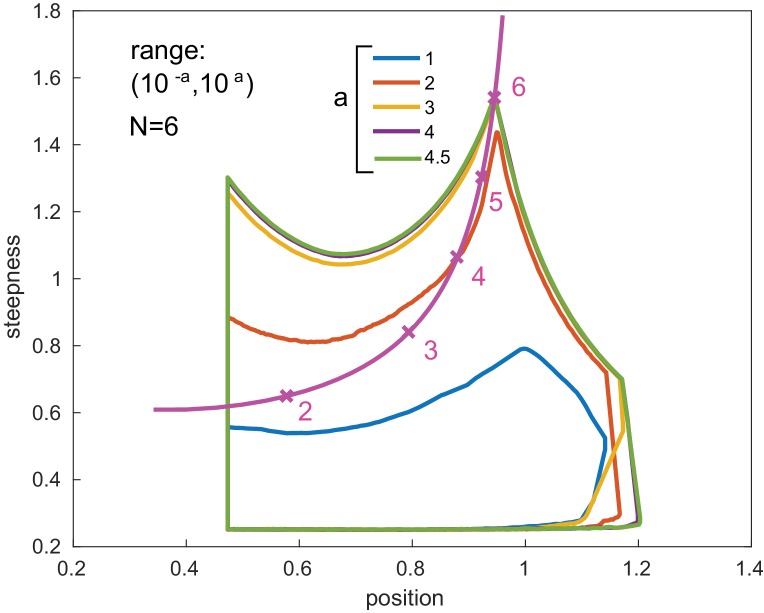
Boundary stabilization.Position-steepness boundaries are shown for GRFs generated by six transcription factor binding sites, as in Figure 6, for varying parametric ranges. The boundaries stabilise rapidly as the parametric range is increased from a = 3, which is the value used in Figure 6, to a = 4 and a = 4.5. The purple boundary for a = 4 is obscured by the green boundary for a = 4.5. The magenta curve marks the Hill line, as in Figure 6.